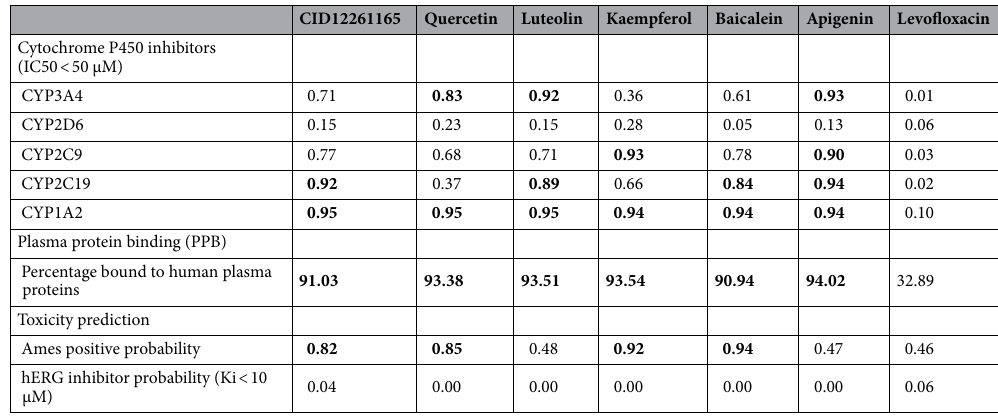
Table 4. In-silico drug profiling analysis of the flavonoids. Bold in Cytochrome P450, protein binding, and Ames are inhibitor, > 90%, and mutagenic, respectively.